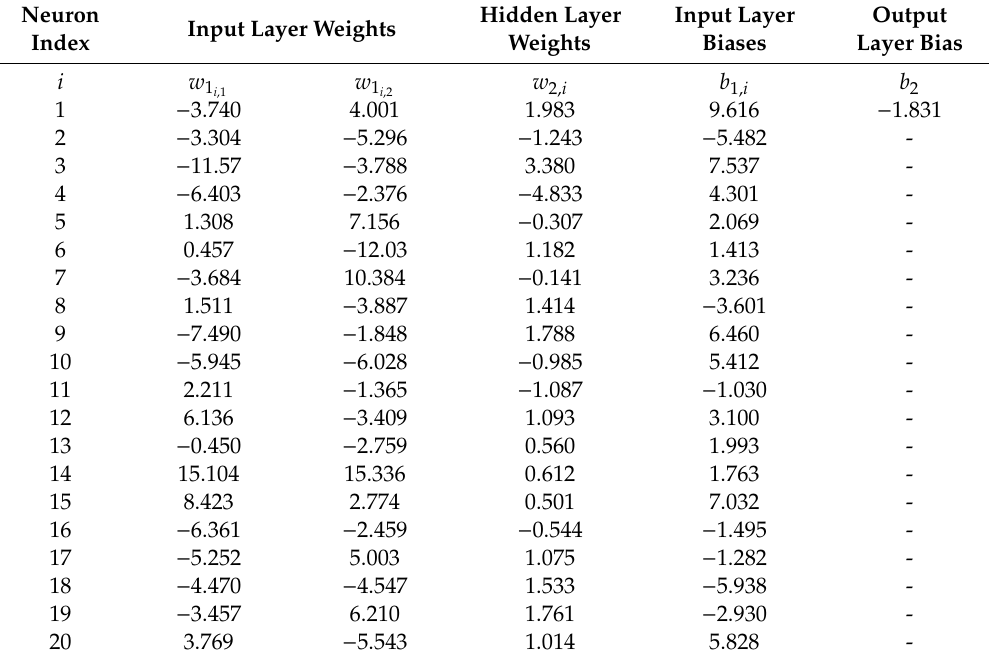
Table 6. The optimized coe ffi cients for estimating the normalized PV n in Equation (18).